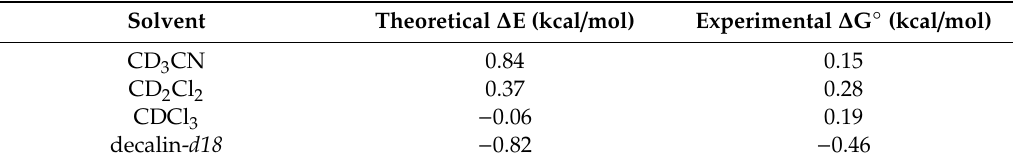
Figure 1. Optimized structures of the tautomers of 3k , 3e , and 3b in CHCl 3 with the relative energies to 3k and their dipole moments. Table 1. Relative energies ∆ E (from the theoretical calculations) and free energies ∆ G ◦ (from 1 H-NMR spectra) of the tautomer 3k relative to 3e in various solvents. A positive value indicates that the keto form is more